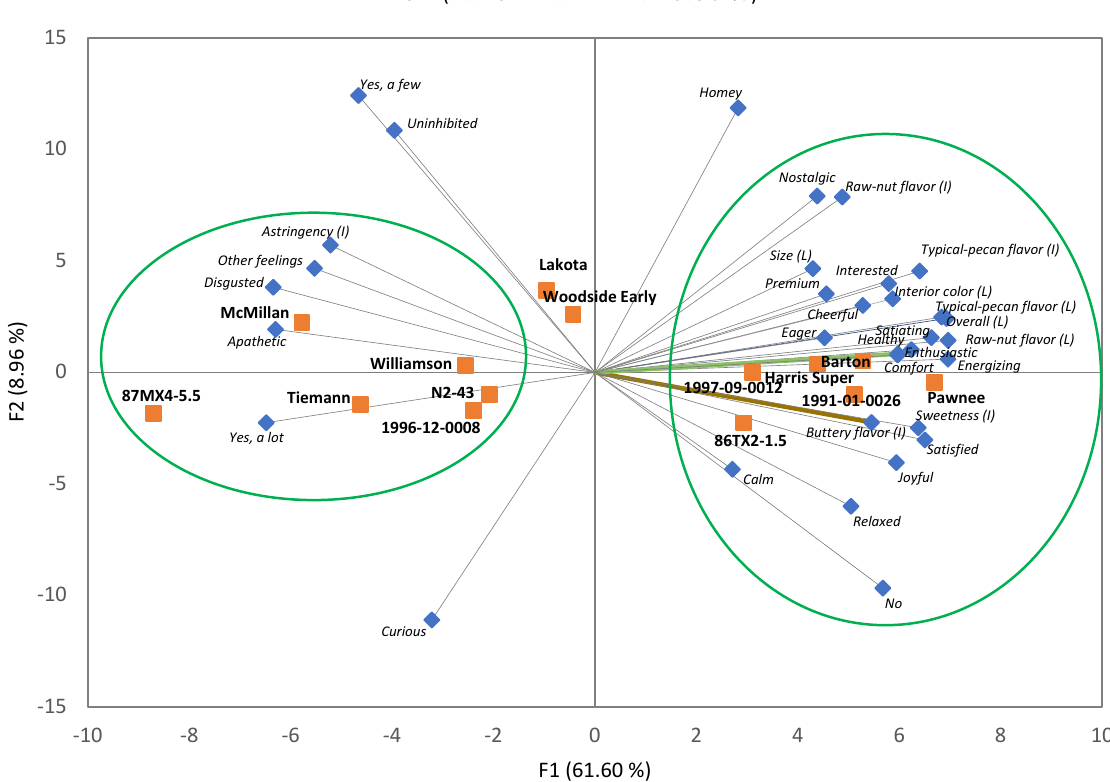
Figure 4. Principal component analysis (PCA) biplot of mean scores of 33 attribute ratings for 14 pecan samples. L: liking; I: intensity; No: no off-flavors; Yes, a few: yes, a few off-flavors; Yes, a lot: yes, a lot of off-flavors. According to PCA output of “Squared cosines of the variables” and “Squared cosines of the observations,” two oval circles with solid lines were created based on variables (attributes) and observations (samples) significantly separated from other samples either at positive or negative side of PC1.